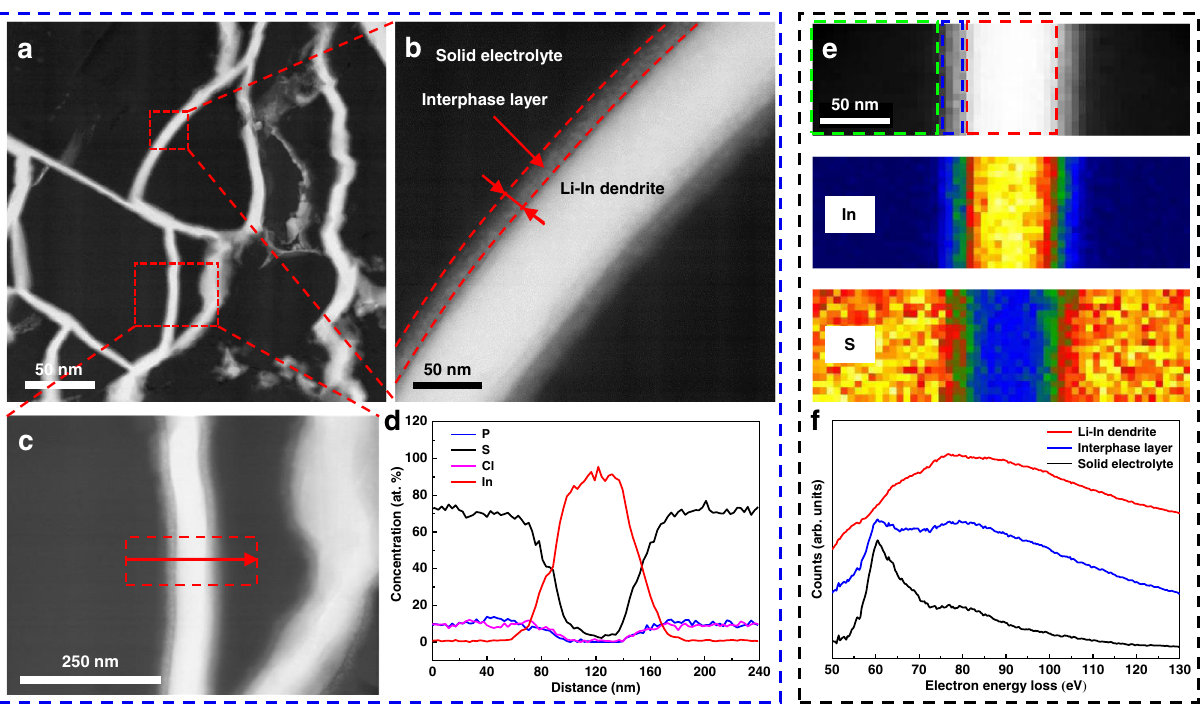
Fig. 4 STEM-HAADF images and EELS analysis of Li-In dendrites. a STEM-HAADF images of Li-In dendrites. b Magni fi ed Li-In dendrite with interphase layer. c Magni fi ed Li-In dendrite used for performing EDX. d EDX mapping of P, S, Cl, and In in the direction of the red arrow. e STEM-HAADF images of Li- In dendrites and corresponding EELS mapping of In and S. f Electron energy loss spectra for Li-In dendrites, LPSCl electrolyte and their interphase